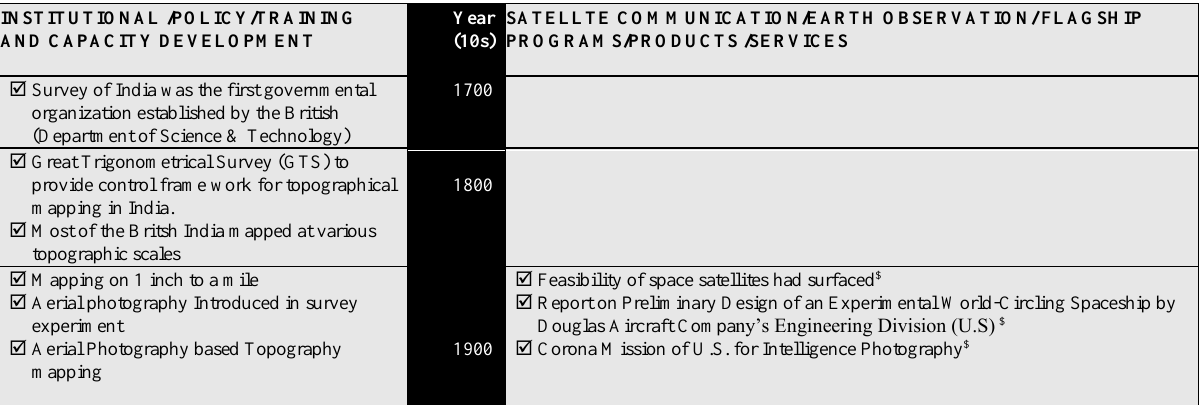
Table 1: Chronological summary (Decadal) of institutional /policy/training and capacity development vis-à-vis. earth observation/ flagship programs/products /services development in